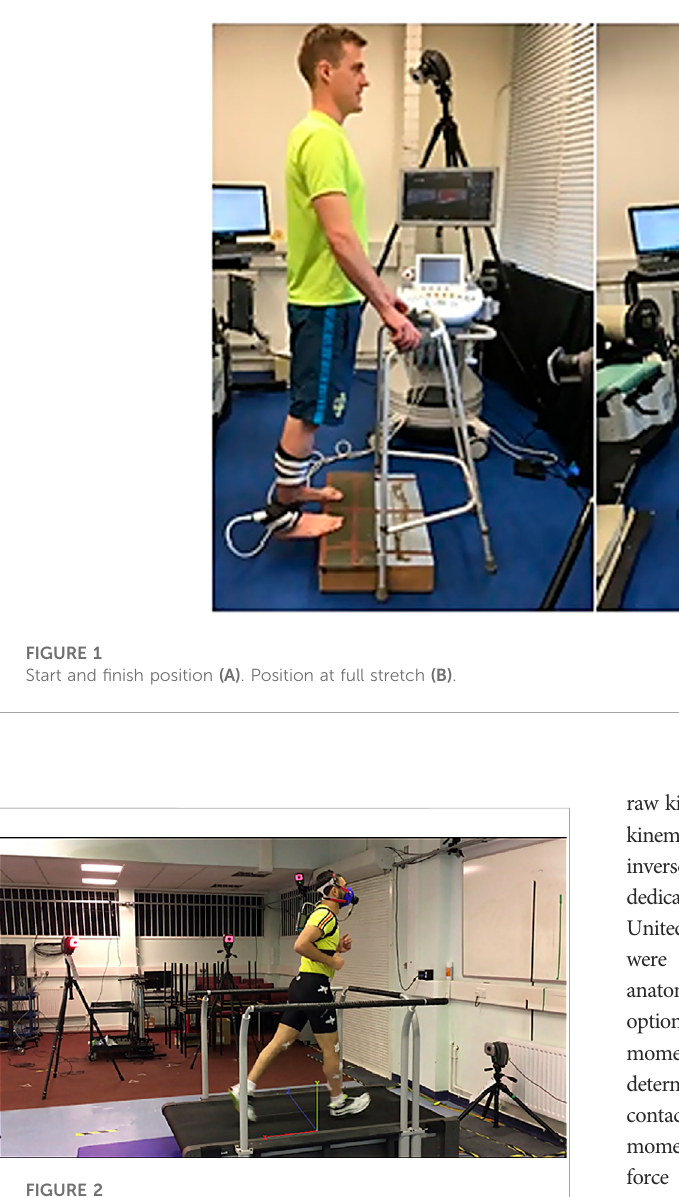
FIGURE 2 Laboratory set-up with the lab-coordinate system shown on the